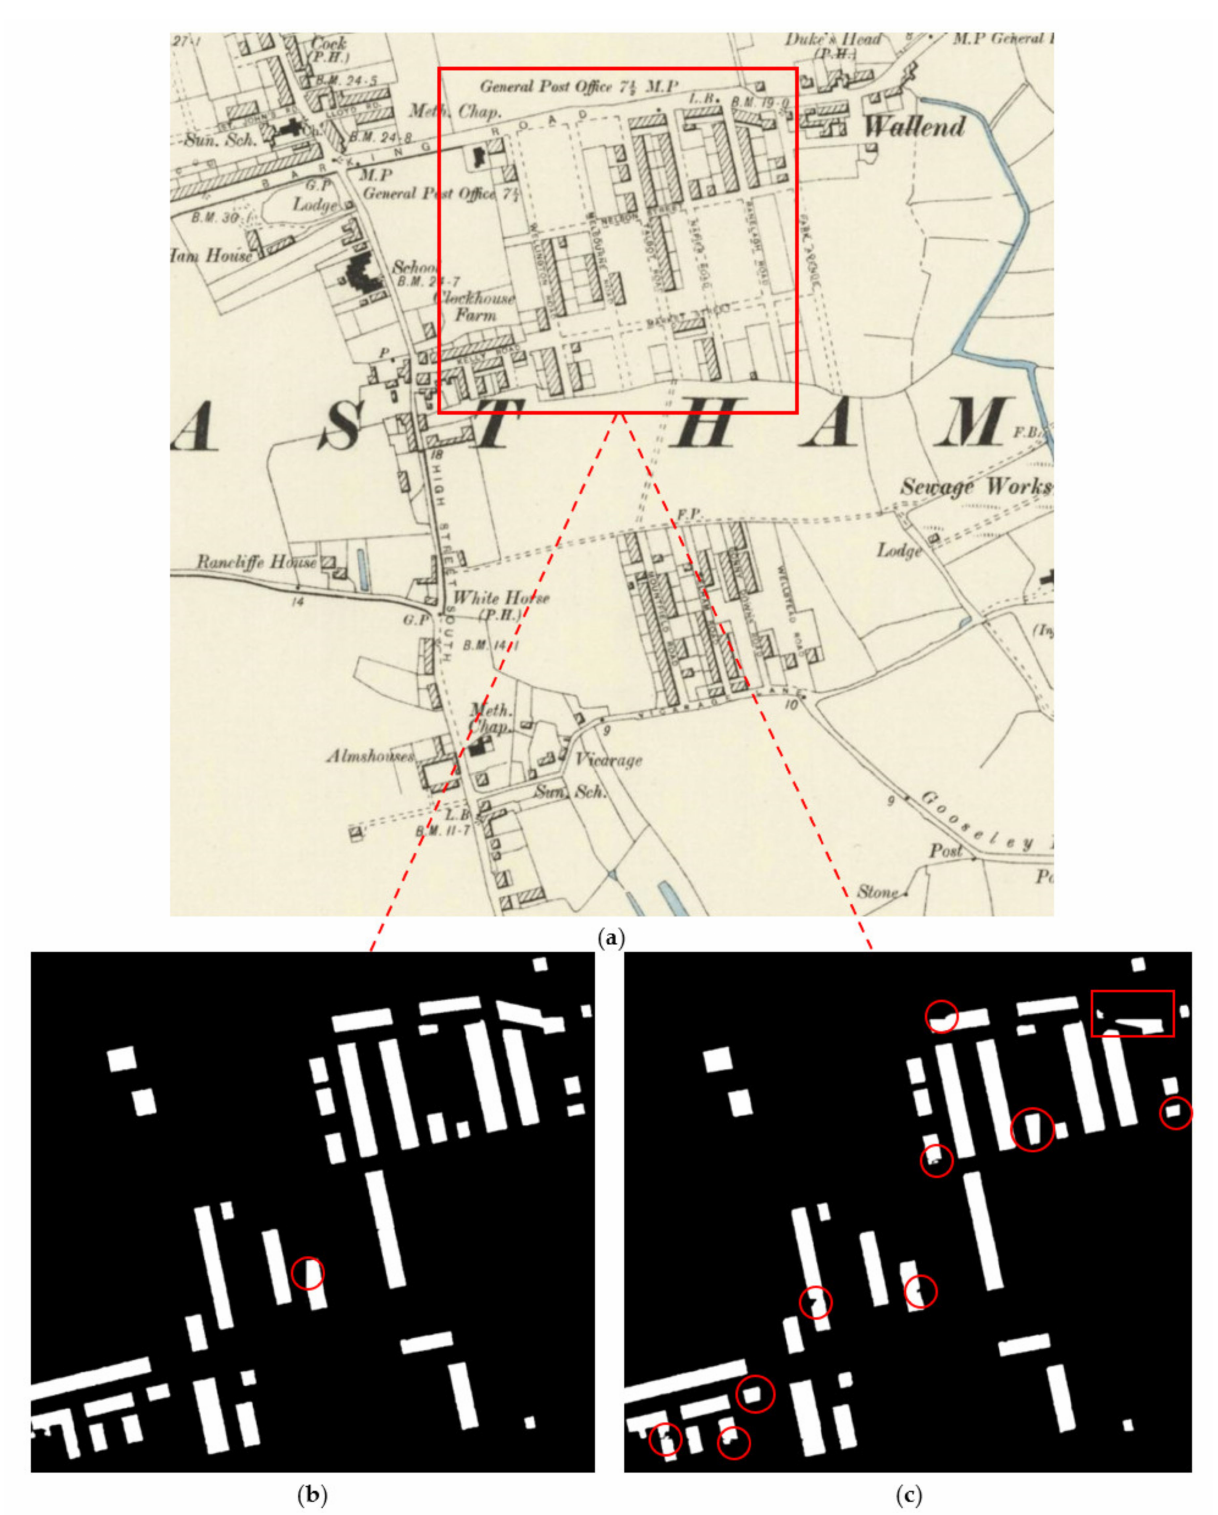
Figure 11. Comparison of extraction results with different numbers of segmentation tiles. ( a ) Experimental area; ( b ) identification result when the map image was cut into 16 tiles; ( c ) identification result when the map image was cut into 100